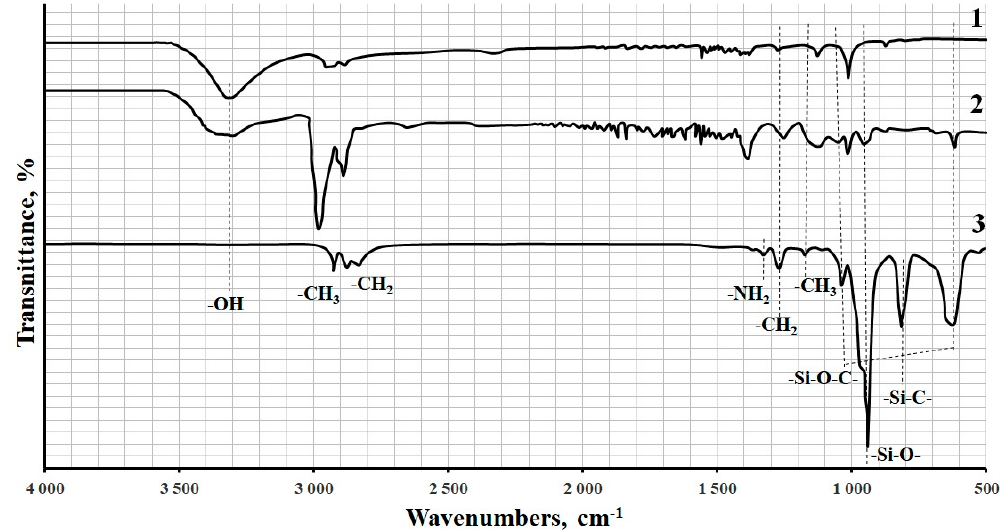
Figure 6. FT-IR spectroscopy: 1-pristine MWCNTs ; 2-APTES-treated MWCNTs ; 3-APTES.